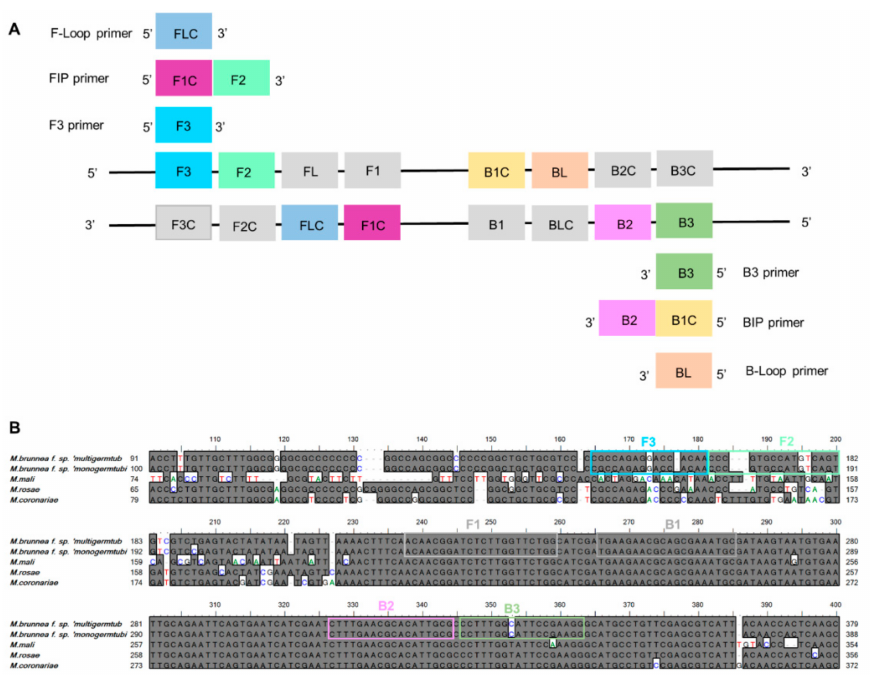
Figure 1. Design of LAMP primers specific for Marssonina brunnea based on internal transcribed spacer ( ITS ) sequences. ( A ) Schematic representation of LAMP-amplified regions. For ease of explanation, six distinct regions are designated on the target DNA, labeled F3 (forward outer primer), F2, F1, B1C, B2C, and B3 (backward outer primer) from the 5’ end. As C represents a complementary sequence, F1C and B1C are complementary to F1 and B1, respectively. Two inner primers (FIP (forward inner primer) and BIP (backward inner primer)) and outer primers (F3 and B3) are used in the LAMP method. FIP (BIP) is a hybrid primer consisting of the F1C (B1C) sequence and the F2 (B2) sequence. FL and BL represent forward and backward loop primers, respectively. ( B ) Nucleotide sequence alignment of ITS sequences from M. brunnea f. sp. multigermtubi , M. brunnea f. sp. monogermtubi , and three closely related species. In the aligned sequences, grey shade indicates a match, and a dash indicates a gap sequence. Polymorphic sites among the five species are highlighted in color. The rectangular boxes with different colors correspond to the different primer sequences of the LAMP primer set shown in A.